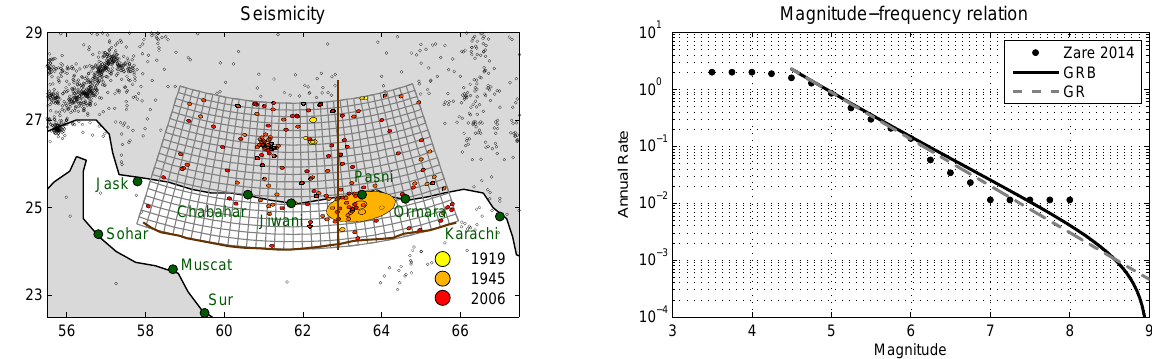
Figure 1. Left: seismicity (Zare et al., 2014). The brown lines are the profile and deformation front by Smith et al. (2013), in grey the subduction interface. The color of the selected events corresponds to year, and size is by scaling relations (Blaser et al., 2010). Right: inferred magnitude–frequency relation. Solid: Gutenberg–Richter–Bayes (used), grey: Gutenberg–Richter (for comparison).